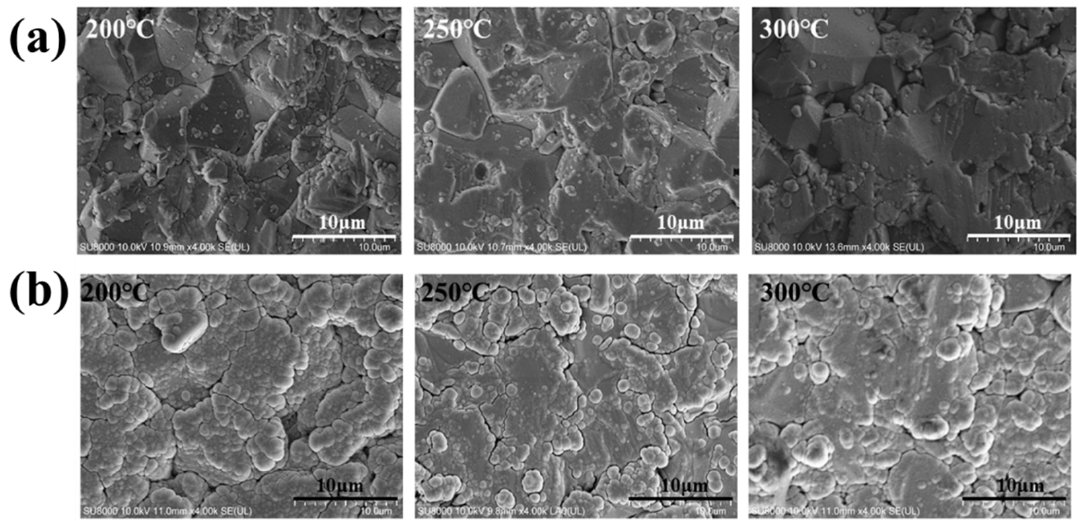
Figure 5. SEM images of thin films ( a ) Cu ( b ) CuNi at different heat treatment temperatures.